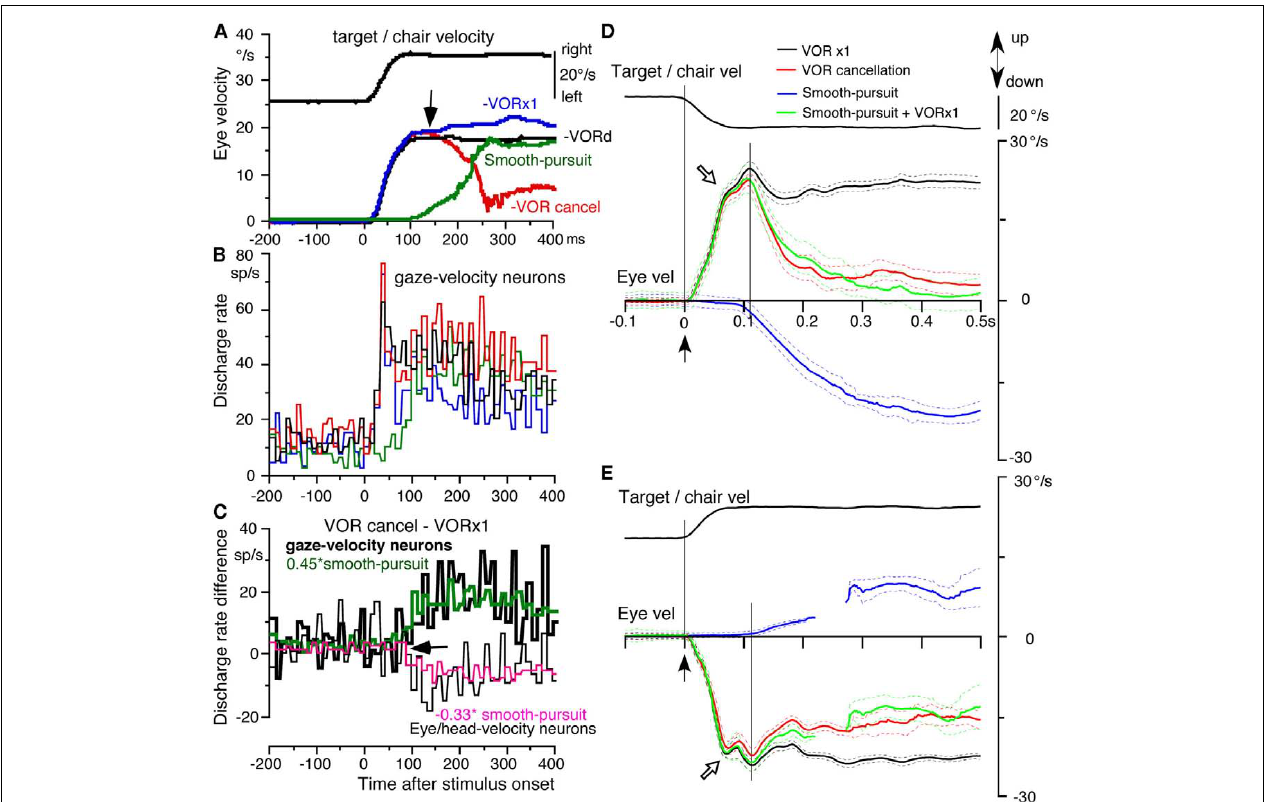
FIGURE 2 |Whole-body rotation, population responses of caudal FEF pursuit neurons and vertical eye velocity of juvenile monkeys. (A–C) Horizontal whole-body rotation and target motion were applied in a velocity step trajectory (top). (A) Plots de-saccaded and averaged eye velocity during smooth-pursuit (green),VOR cancelation (red),VOR × 1 (blue), and during whole-body rotation in complete darkness without a target (VORd, black). Arrow indicates the divergent point for eye velocity betweenVOR cancelation and × 1. (B) Averaged discharge rates of nine gaze-velocity neurons duringVOR × 1 (blue),VOR cancelation (red), and VORd (black) and smooth-pursuit (green). (C) Plots difference in mean discharge rate betweenVOR cancelation and × 1 for nine gaze-velocity neurons (thick line) and nine eye/head-velocity neurons (thin line). Green trace in (C) shows that the discharge rate difference of gaze-velocity neurons (thick line) was well predicted by 0.45 * smooth-pursuit responses, whereas pink trace in (C) shows that the discharge rate difference of eye/head-velocity neurons was predicted by − 0.33 * smooth-pursuit responses. (D)